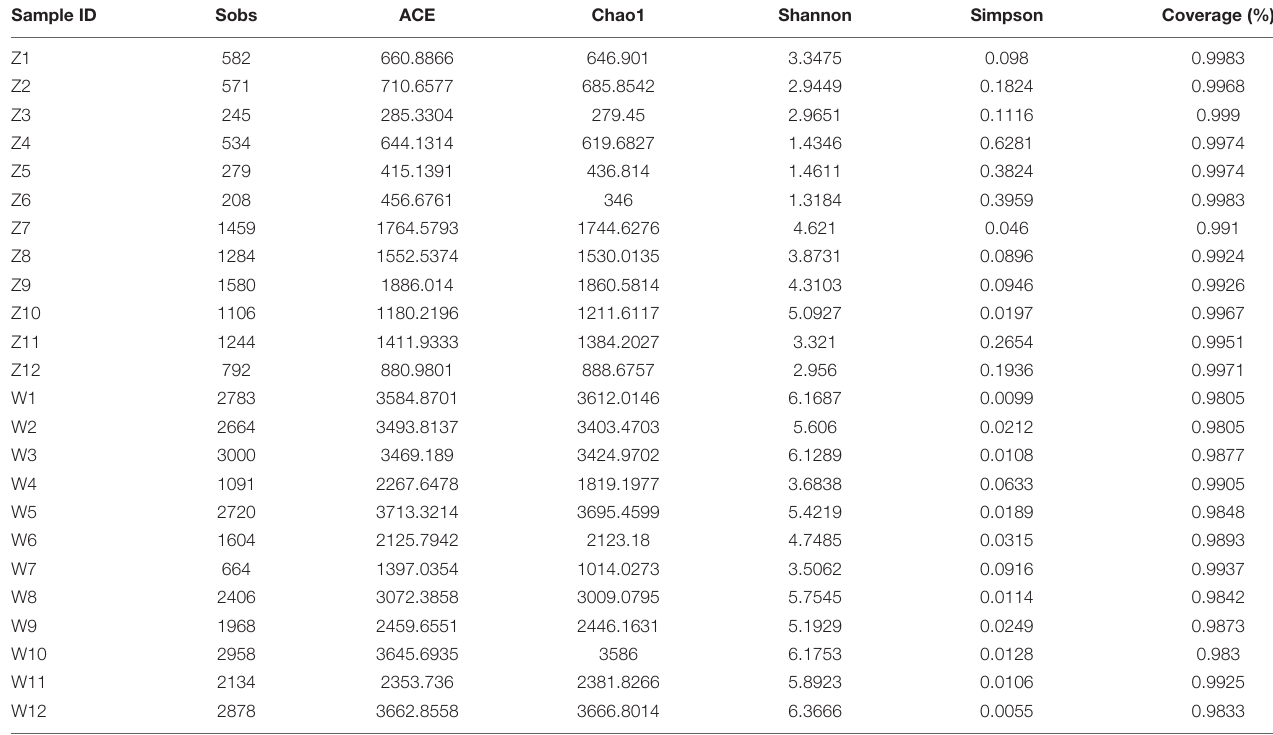
TABLE 3 | Estimated OTU richness and diversity indices for each fecal sample of oriental white storks. Sample